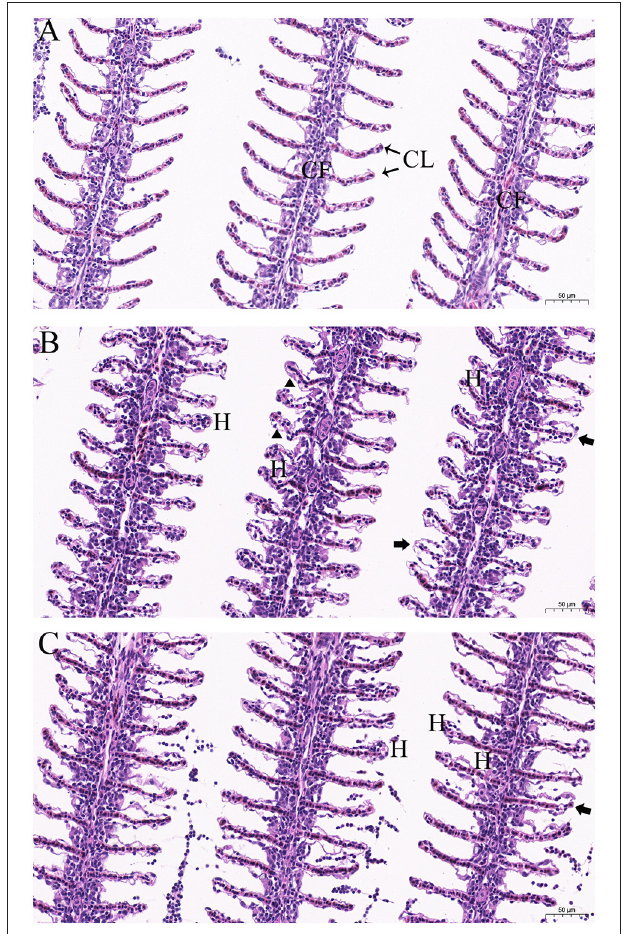
FIGURE 6 | Histopathological characteristics in the gills of goldfish ( Carassius auratus ) after exposure to different concentrations of dioscin. (A) goldfish gills exposed to 0.06% DMSO for 96h (control group), gill filament (GF) and gill lamellae (GL); (B) goldfish gills exposed to 0.6 mg/L dioscin for 96h, hyperplasia (H), curling and abnormal elongation of the secondary lamellae (triangles) and detachment of lamellar epithelium (arrows); (C) goldfish gills exposed to 0.7 mg/L dioscin for 1h, hyperplasia (H) and detachment of lamellar epithelium